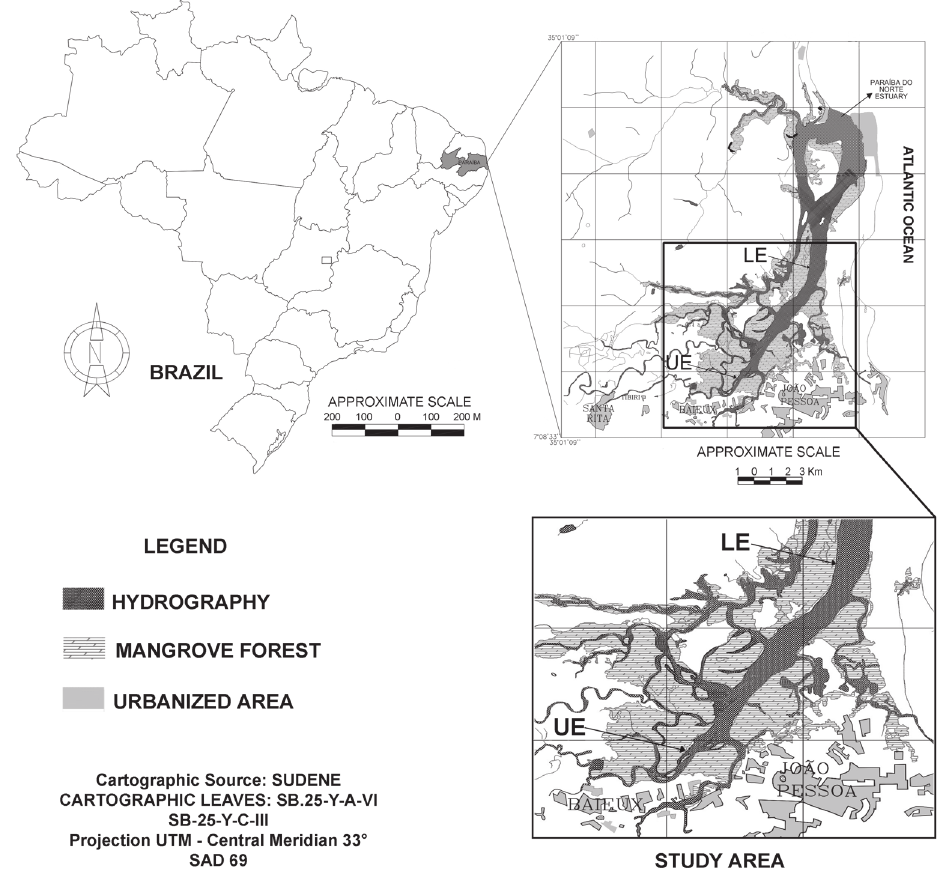
Figure 1. Geographical location of Paraíba do Norte River Estuary, Brazil. (LE) Lower Estuary, (UE) Upper